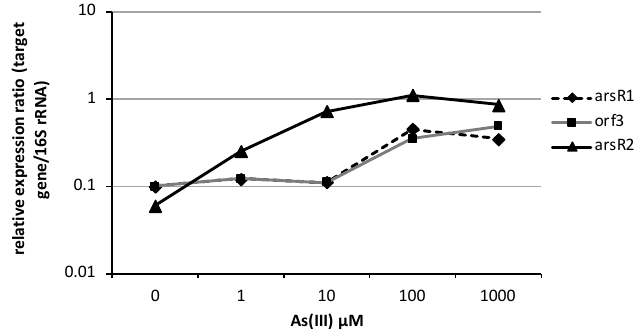
Figure 2. Putative promoter regions (-35, -10) and the transcription start point (+1) of ( a ) arsR1 and ( b ) arsR2 . The arrows showed the transcription start sites (+1), and the colored words showed the area of arsR1 and arsR2 , respectively.